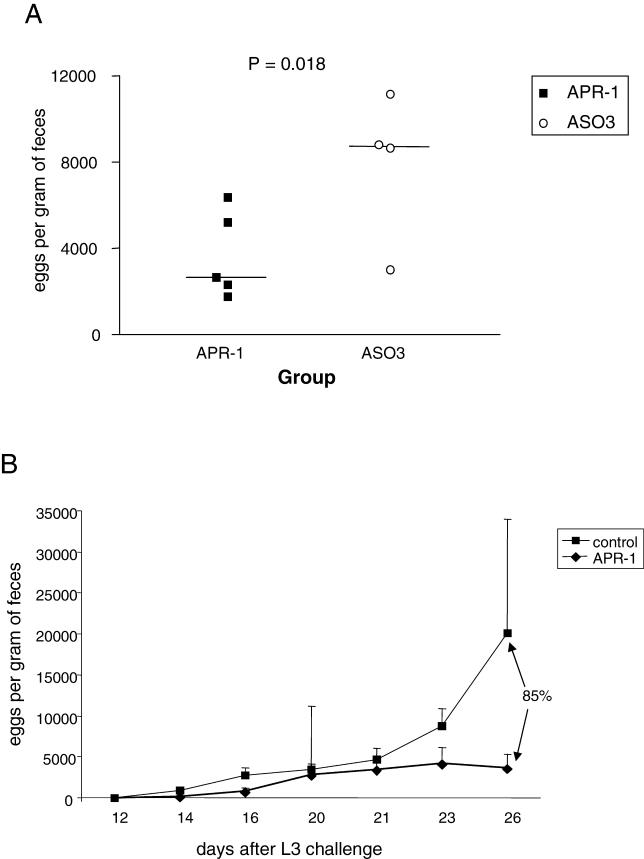
Vaccination with APR-1 Reduces Fecal Egg Counts of Dogs after Challenge Infection with HookwormsStatistically significant reduction (p = 0.018) in median fecal egg counts sampled on days 21, 23, and 26 of dogs vaccinated with APR-1 compared to dogs that received adjuvant alone.(A). Geometric mean values of fecal egg counts from vaccinated and control dogs between challenge infection and necropsy.(B). Error bars refer to the standard error of the mean.